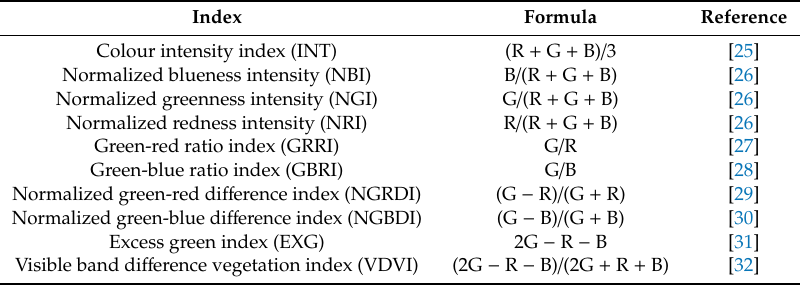
Table 2. Vegetation indices (VIs) of images and their calculation formulas.